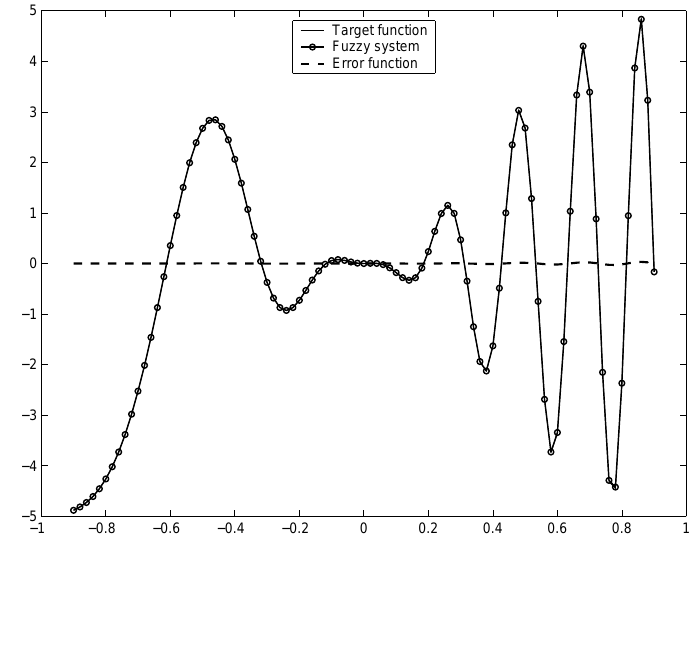
From Figure 13 we can see that the curve of target function f ( x ) (the solid line ( system F ( x ) (the circle line ( ) ) are practically ◦